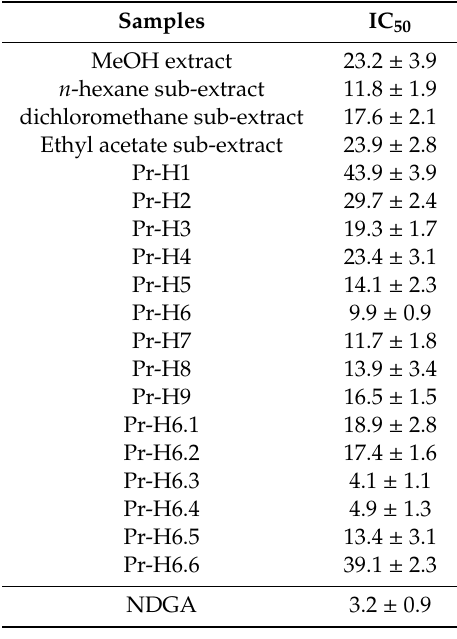
Table 2. LOX enzyme inhibition of P. russeliana extracts and fractions (in g /